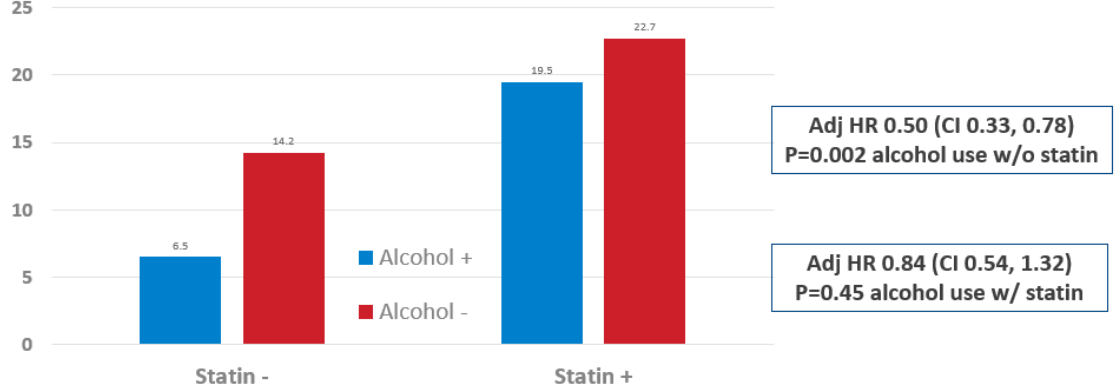
Figure 1. MACE Outcomes in Primary Prevention Patients by Alcohol and Statin Status. Alcohol+ = alcohol user. Alcohol − = Alcohol non-user.